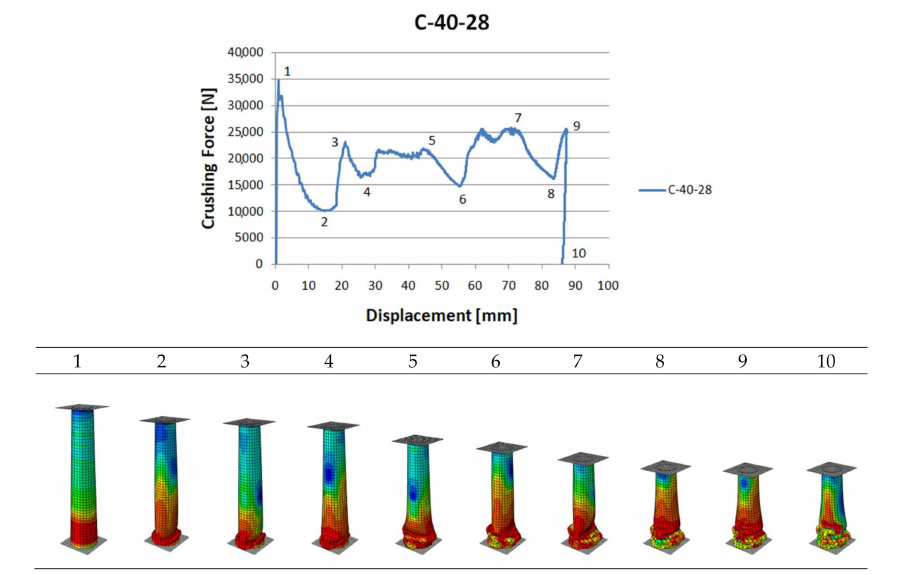
Figure 8. Crushing force—shortening characteristics and di ff erent crushing modes.